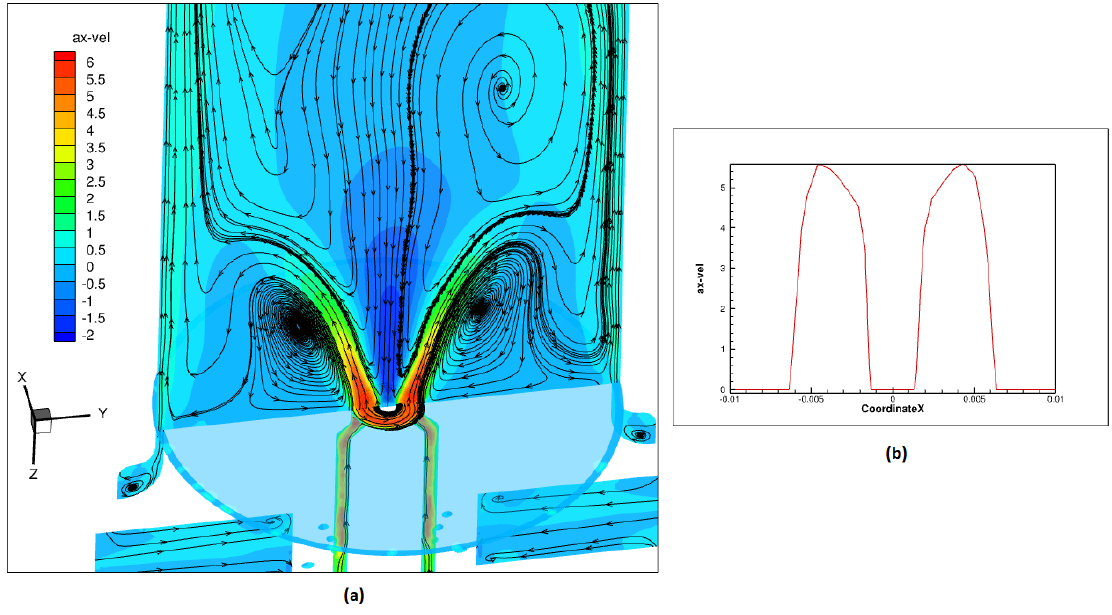
Figure 8. Axial velocity profile for the cold flow case with RNG k- (cid:101) turbulence model ( a ) and axial profile 2D plot set at the inlet of the combustion simulations ( b